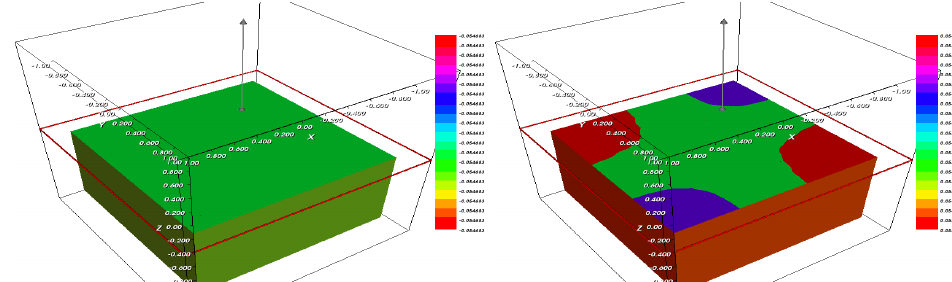
Figure 5. The fraction ϕ ( left ) and ψ ( right ) after T = 40.